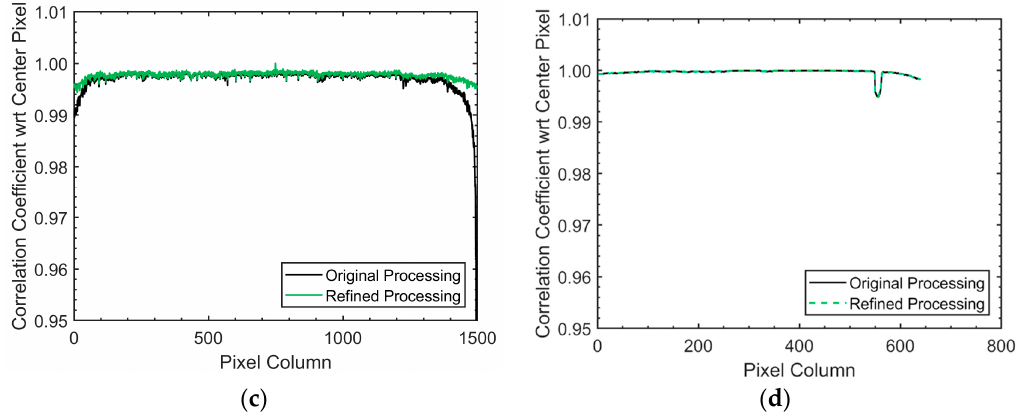
Figure 13. The CCs calculated across the field-of-view with respect to the entire spectrum from the center pixel. ( a ) The CC of the CASI imagery (23 June 2016); ( b ) SASI imagery (23 June 2016); ( c ) CASI imagery (24 June 2016); ( d ) SASI imagery (24 June 2016). ( a,c ) The CASI imagery was characterized by systematic reductions near the edges of the FOV. These revealed potential errors consistent with the spectral smile effect and other cross-track illumination effects. This reduction was most substantial for the CASI images generated by the old processing methodology. Compared to the imagery from the 24th, the CCs were more uniform across the FOV for the CASI data from the 23rd. ( b,d ) The SASI imagery was consistent across all dates and processing methodologies. There was a notable reduction in the CCs across the FOV from Pixels 548–564. This revealed the spatial location of an error. Table 3. Spatial and spectral localization of large imaging errors. Spatial errors were detected from the data in Figure 13 using the defined threshold. Potential errors were spectrally located through the window-based methodology described in Section 2.4. Errors were detected along the edges of the CASI imagery in the blue end of the spectra. A single band error was detected in the SASI imagery from 993–1008 across Pixels 548–564.